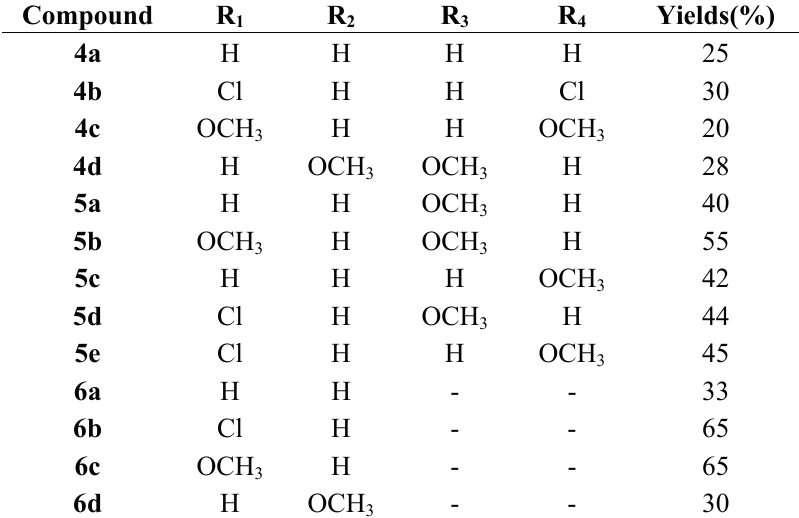
Table 2. Derivatives 4a – d , 5a – e and 6a – d